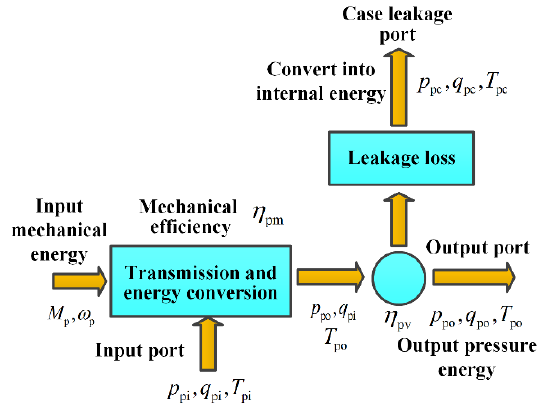
Figure 4. Power losses of piston pump.